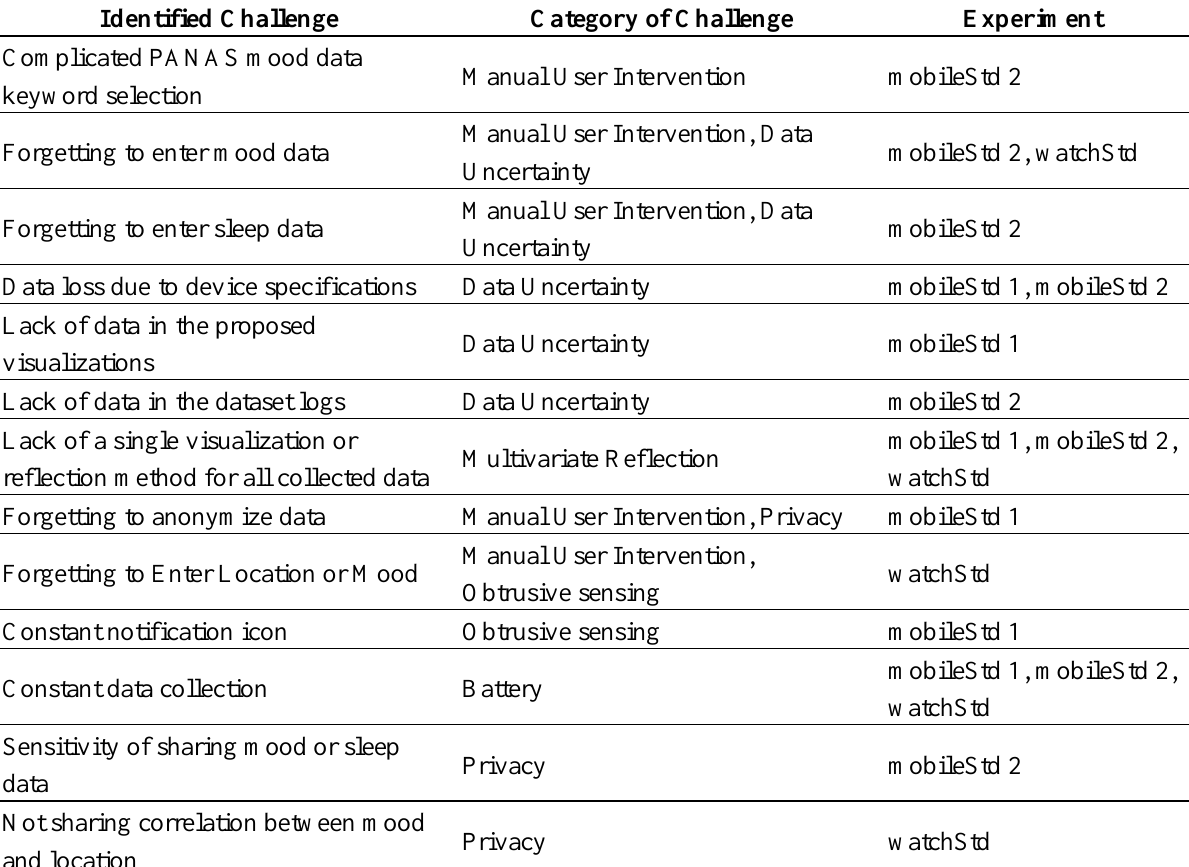
Figure 4. Three days visualization of user lifelog data in mobileStd 2. Table 2. Identified challenges and their occurrences in each